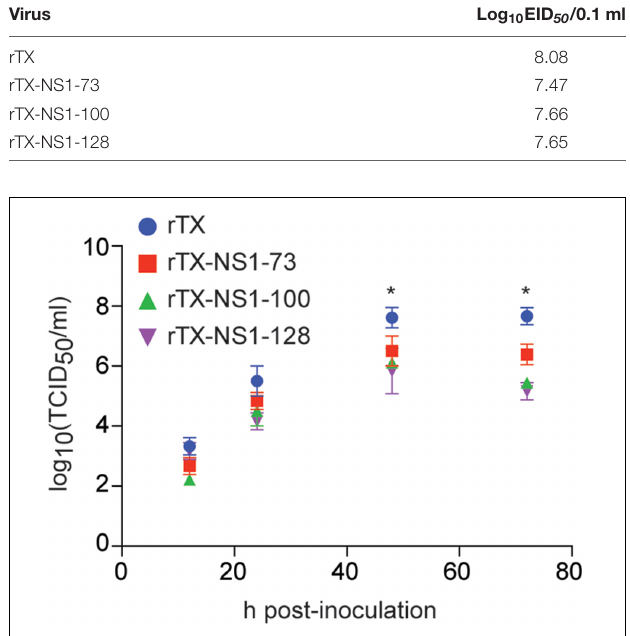
FIGURE 2 | Virus replication in MDCK cells. Cells were infected at a multiplicity of infection of 0.001. Viruses at indicated times post-inoculation were titrated in MDCK cells and expressed as log10 TCID 50 /ml. The mean and standard errors are shown from three independent experiments. Asterisks represent p -values <